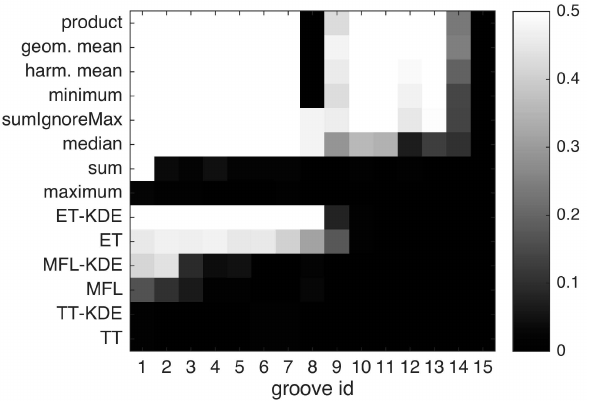
Figure 10. Evaluation of different fusion functions F according to Equation (2), and of single-sensor detection. For each groove and detection method, the AUC-PR-0.5 is shown in shades of gray. Optimal performance is 0.5. Groove numbers correspond to Table 1, that is groove nr. 1 is the deepest and nr. 15 is the shallowest.